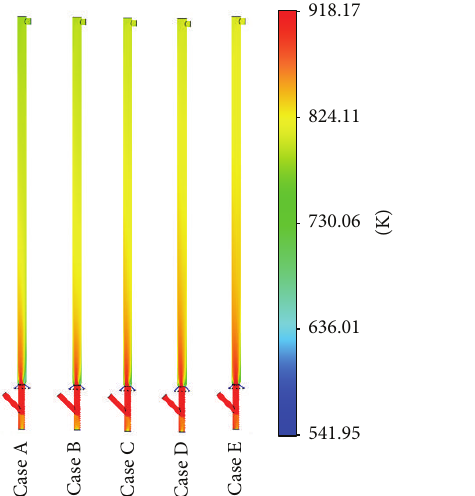
Figure 19: Product yields for each catalyst-to-oil ratio.